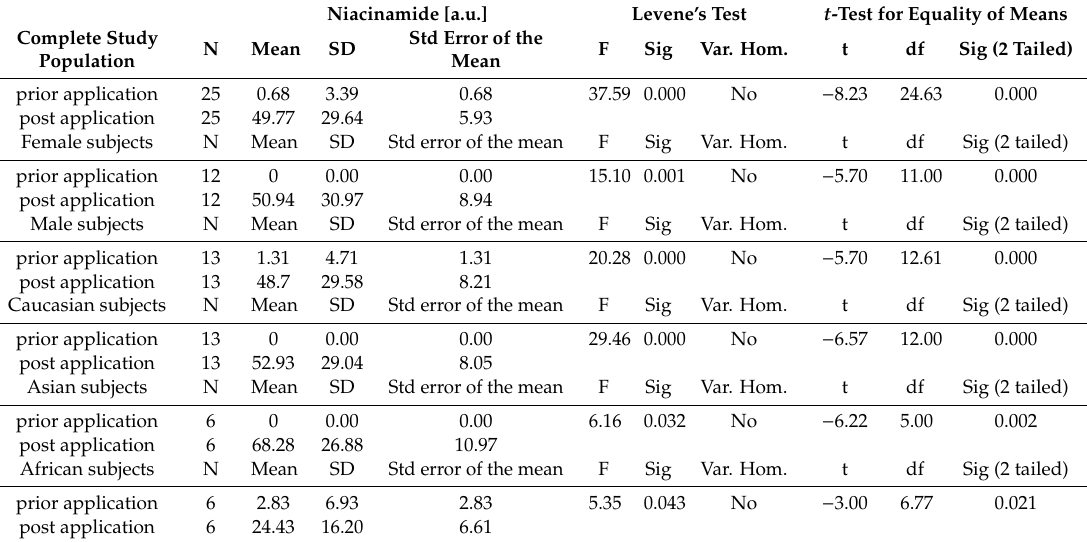
Table 1. Statistical analysis of niacinamide content obtained from the